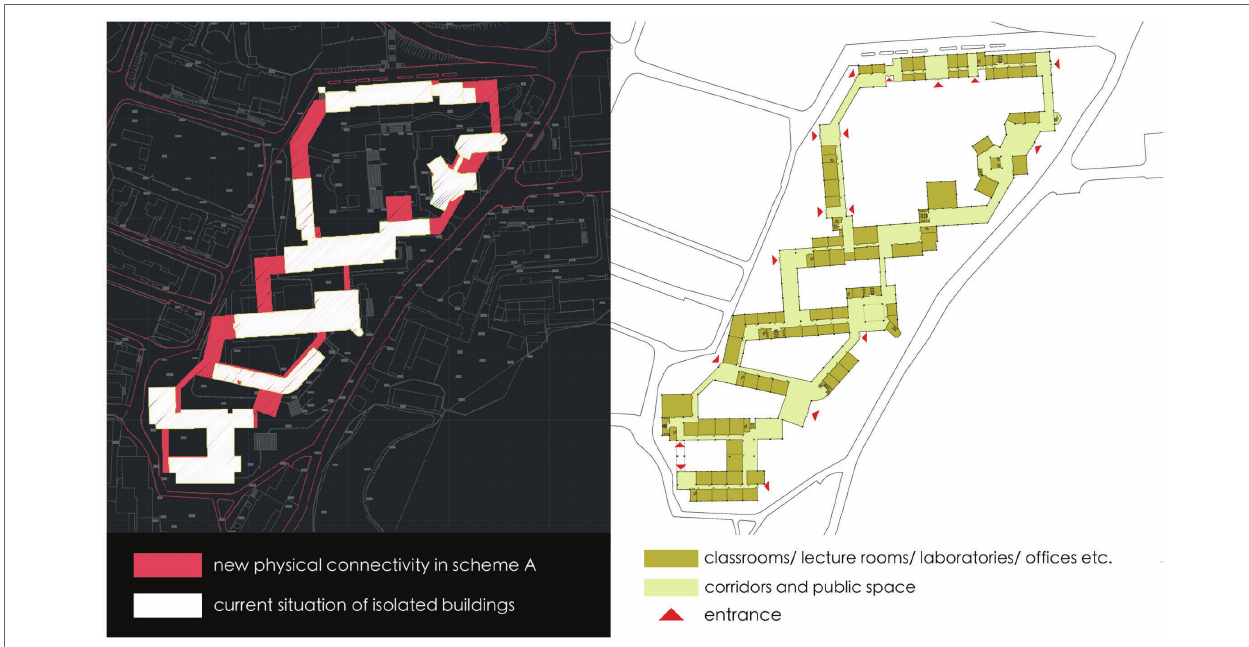
FIGURE 6 | The plan of scheme A which connects isolated buildings on both ends.